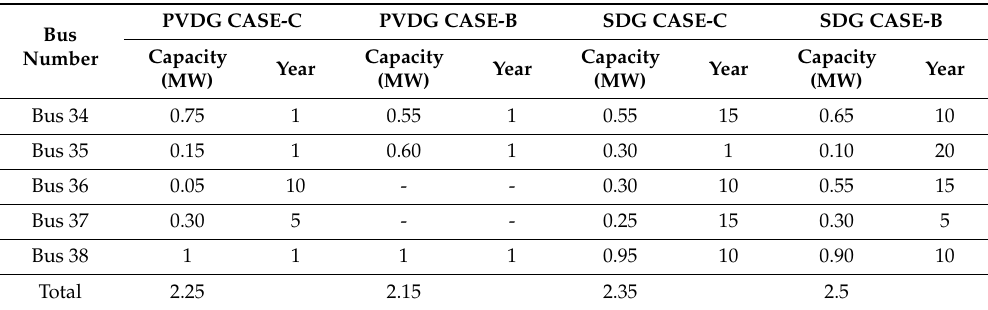
Table 3. Comparison of CASE-B and CASE-C.